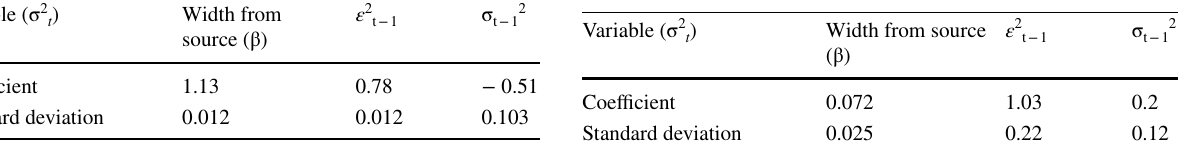
Table 4 Equation of conditional variance of evapotranspiration by